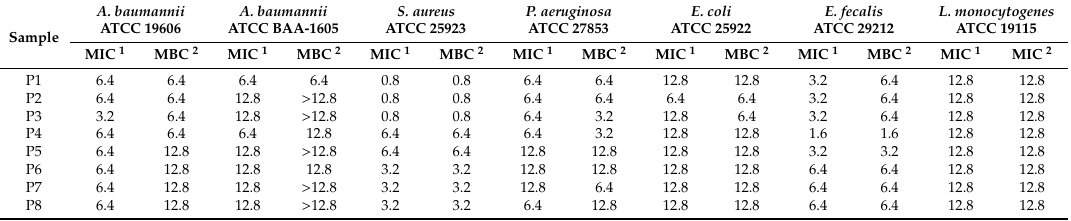
Table 5. The minimum inhibitory concentrations (MICs) and the minimum bactericidal concentrations (MBCs) of ethanol extracts of pomegranate (Punica granatum L.) peels on di ff erent bacteria.